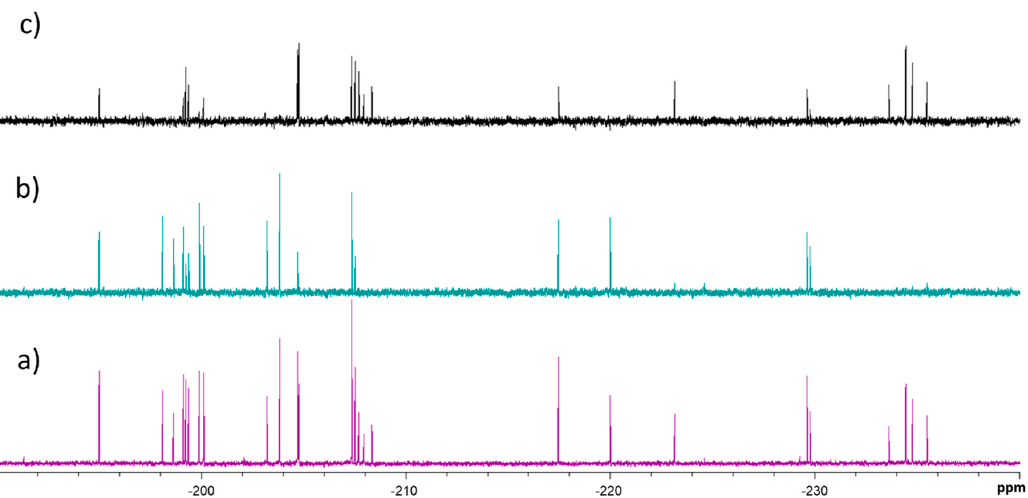
Figure 2. 19 F-NMR relaxation filter experiments performed for the fluorine-containing monosaccharide library in the presence of tetrameric dendritic cell-specific intercellular adhesion molecule 3-grabbing non-integrin (DC-SIGN). The F-sugar / lectin ratio was 47:1. ( a ) Spectrum acquired without T 2 relaxation filter, ( b ) spectrum acquired after 2.4 s of T 2 relaxation filter, and ( c ) di ff erence spectrum. Only the peaks of those molecules that display a significant decrease in their T 2 are present. These peaks correspond to DC-SIGN binders.